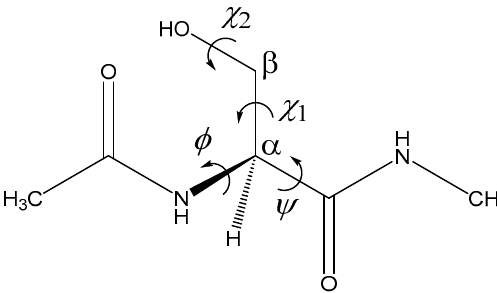
Figure 1. The model compound used in the present study (Ace–Ser–Nme, where Ace = acetyl, Ser = serine, Nme = methylamino). The φ (C–N–C α –C) and ψ (N–C α –C–N) dihedral angles which characterize the main ‐ chain conformation, and the χ 1 (N–C α –C β –O) and χ 2 (C α –C β –O–H) dihedral angles which characterize the side ‐ chain conformation are indicated. The Ser residue is in the L ‐